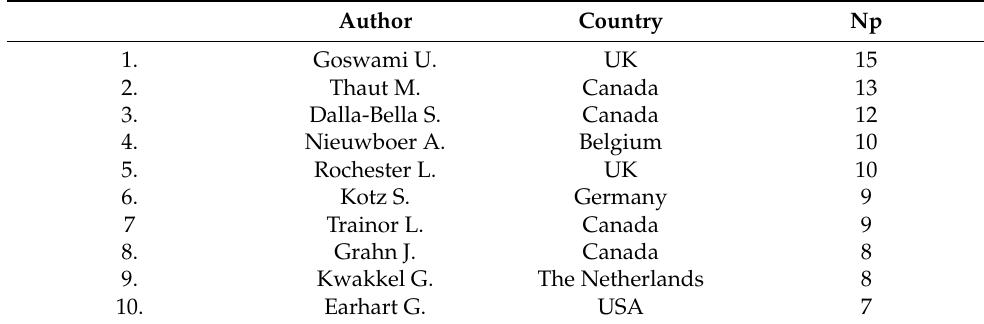
Table 3. Top 10 of most productive authors publishing on rhythmic auditory